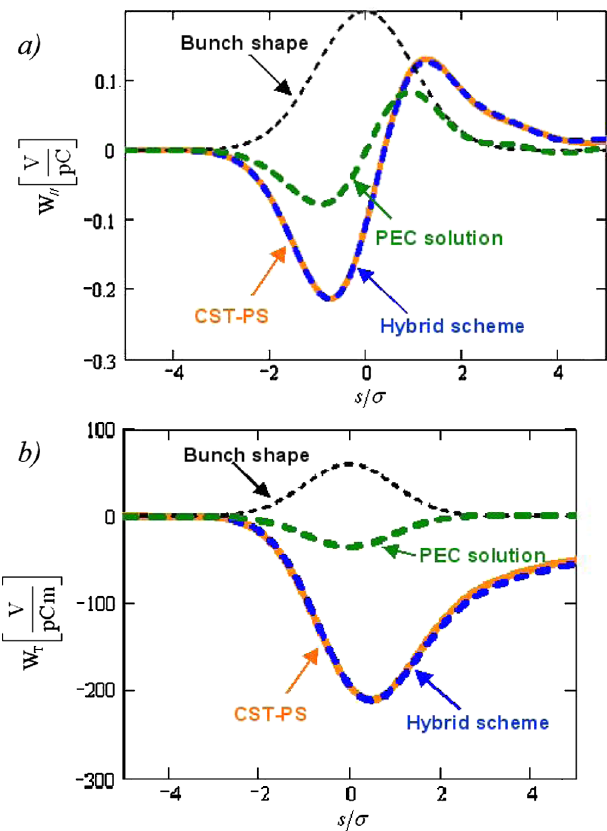
FIG. 15. Comparison of longitudinal wake potential calculated by CST PARTICLE STUDIO (orange solid) and using the hybrid scheme (blue